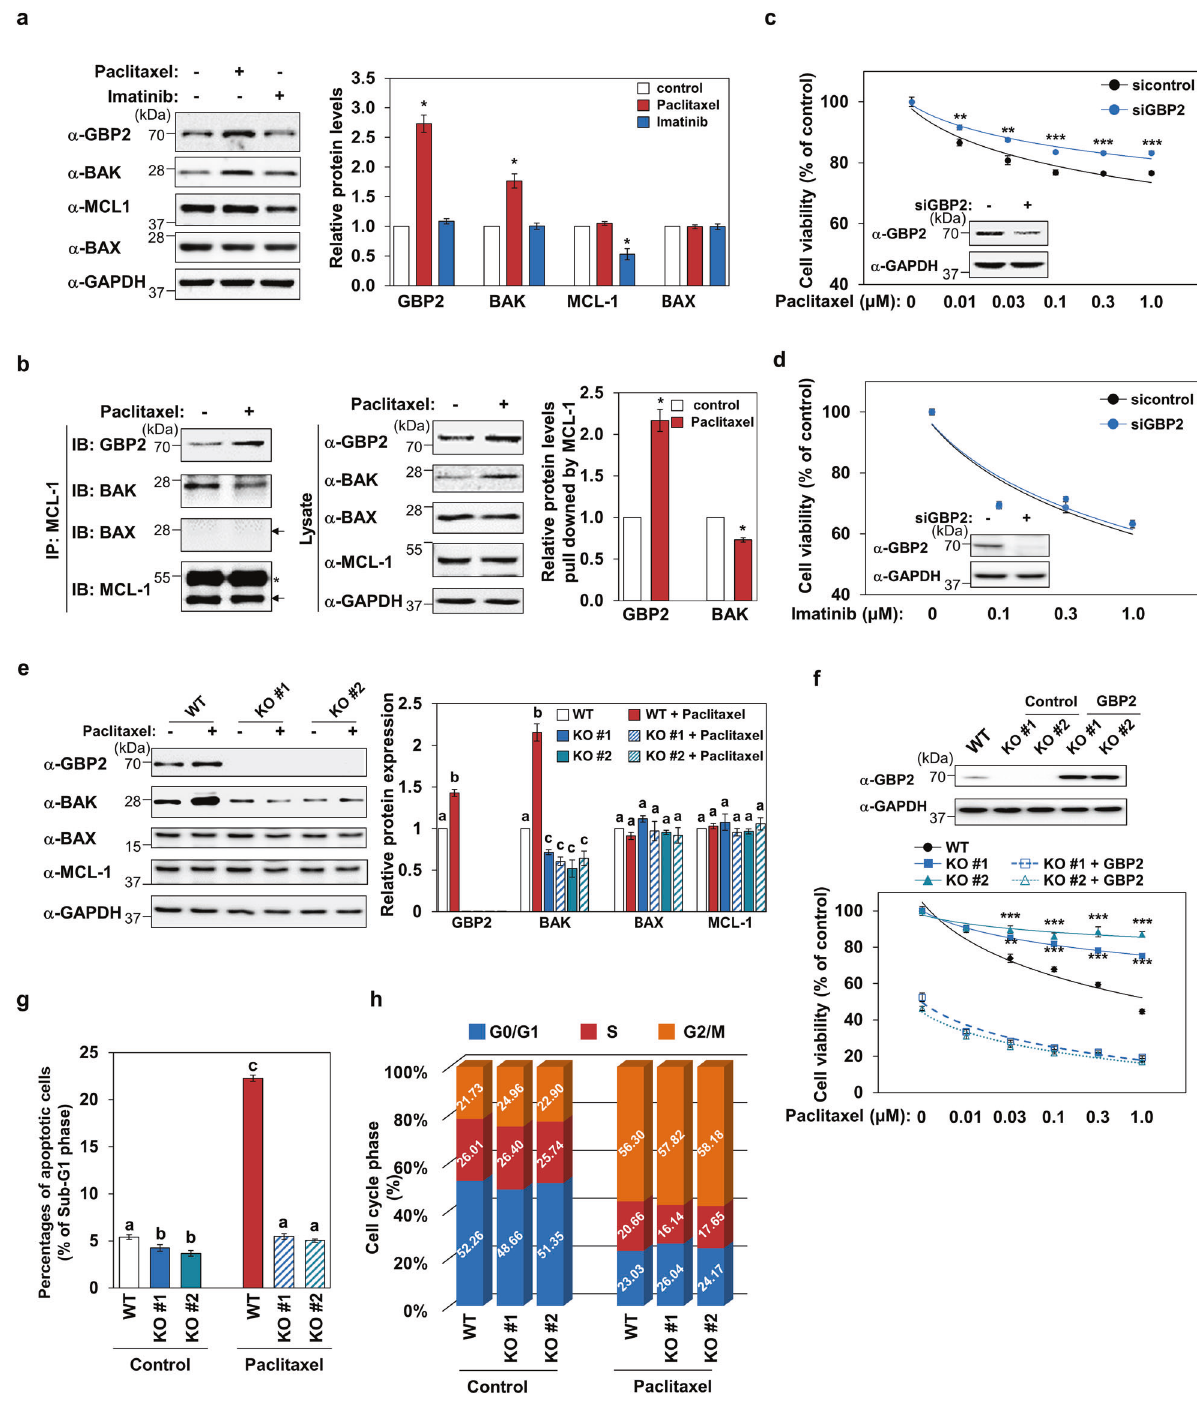
GBPs are underexpressed in leukemia patients and associated with a better prognosis To examine clinical implications of the GBP gene family in leukemia, Affymetrix U133Plus2 microarray datasets comprising bone marrow and blood samples from normal and AML, ALL, and CLL patients were extracted and analyzed using the GENT2 portal [27]. The information of leukemia-related datasets used is described in supplementary Table 1. Due to the lack of available data, CML and GBP7 could not be analyzed. The comparable mRNA levels of most GBP genes, ( GBP1 – 5 ), except for GBP6 ,